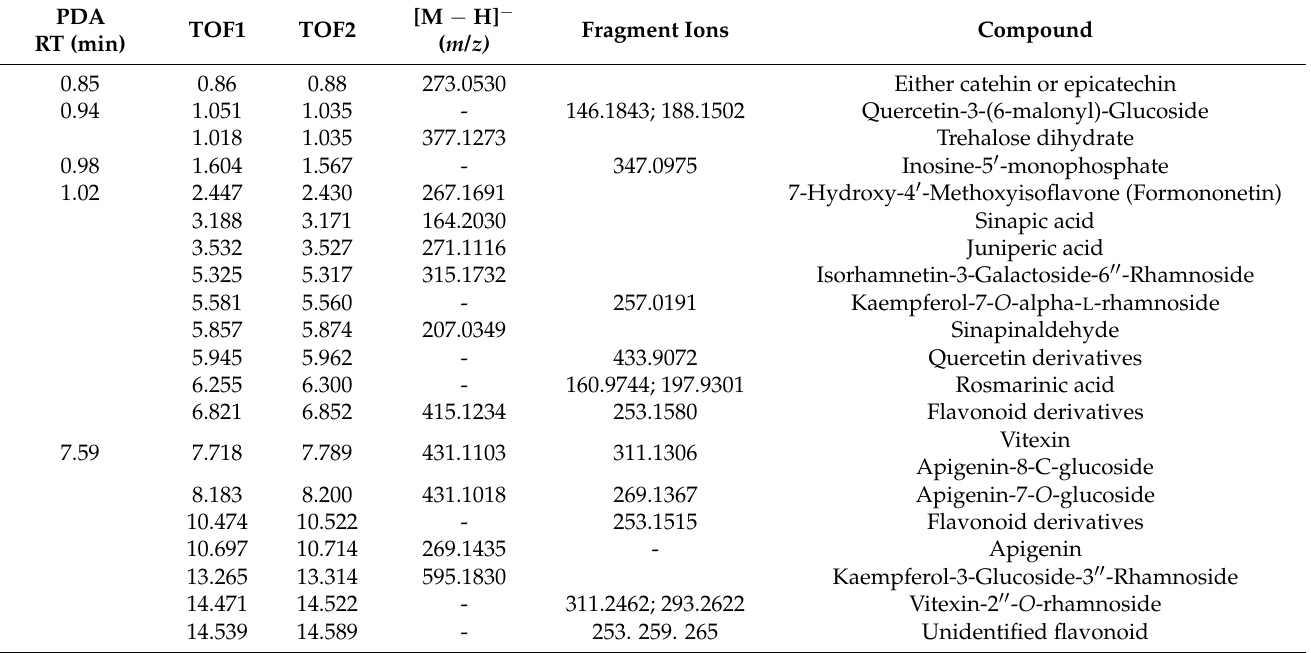
Table 6. The phenolic compounds identified in sausages with buckwheat husk addition.